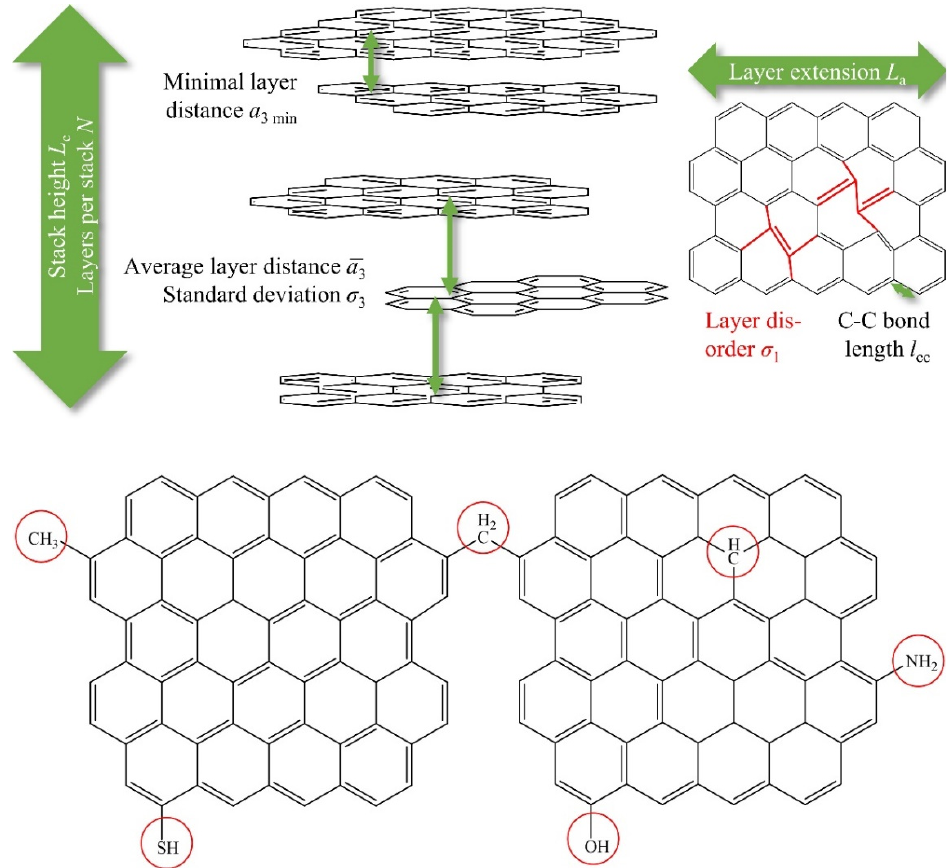
Figure 1. Principle structure of non-graphitic carbons (NGCs) containing a turbostratic stacking arrangement of single (disordered) graphene layers. Also, NGCs can contain unorganized carbon ( sp 3 -hybridized) or foreign atoms (e.g., H, N, O, S). Adapted from [20,21].